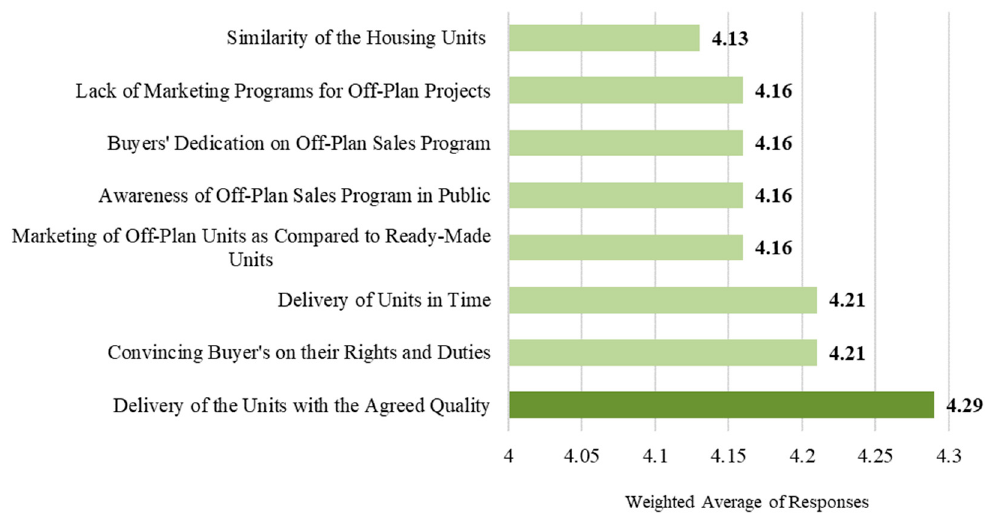
Figure 8. The Weighted Averages of Marketing Challenges based on the Consensus of Experts.